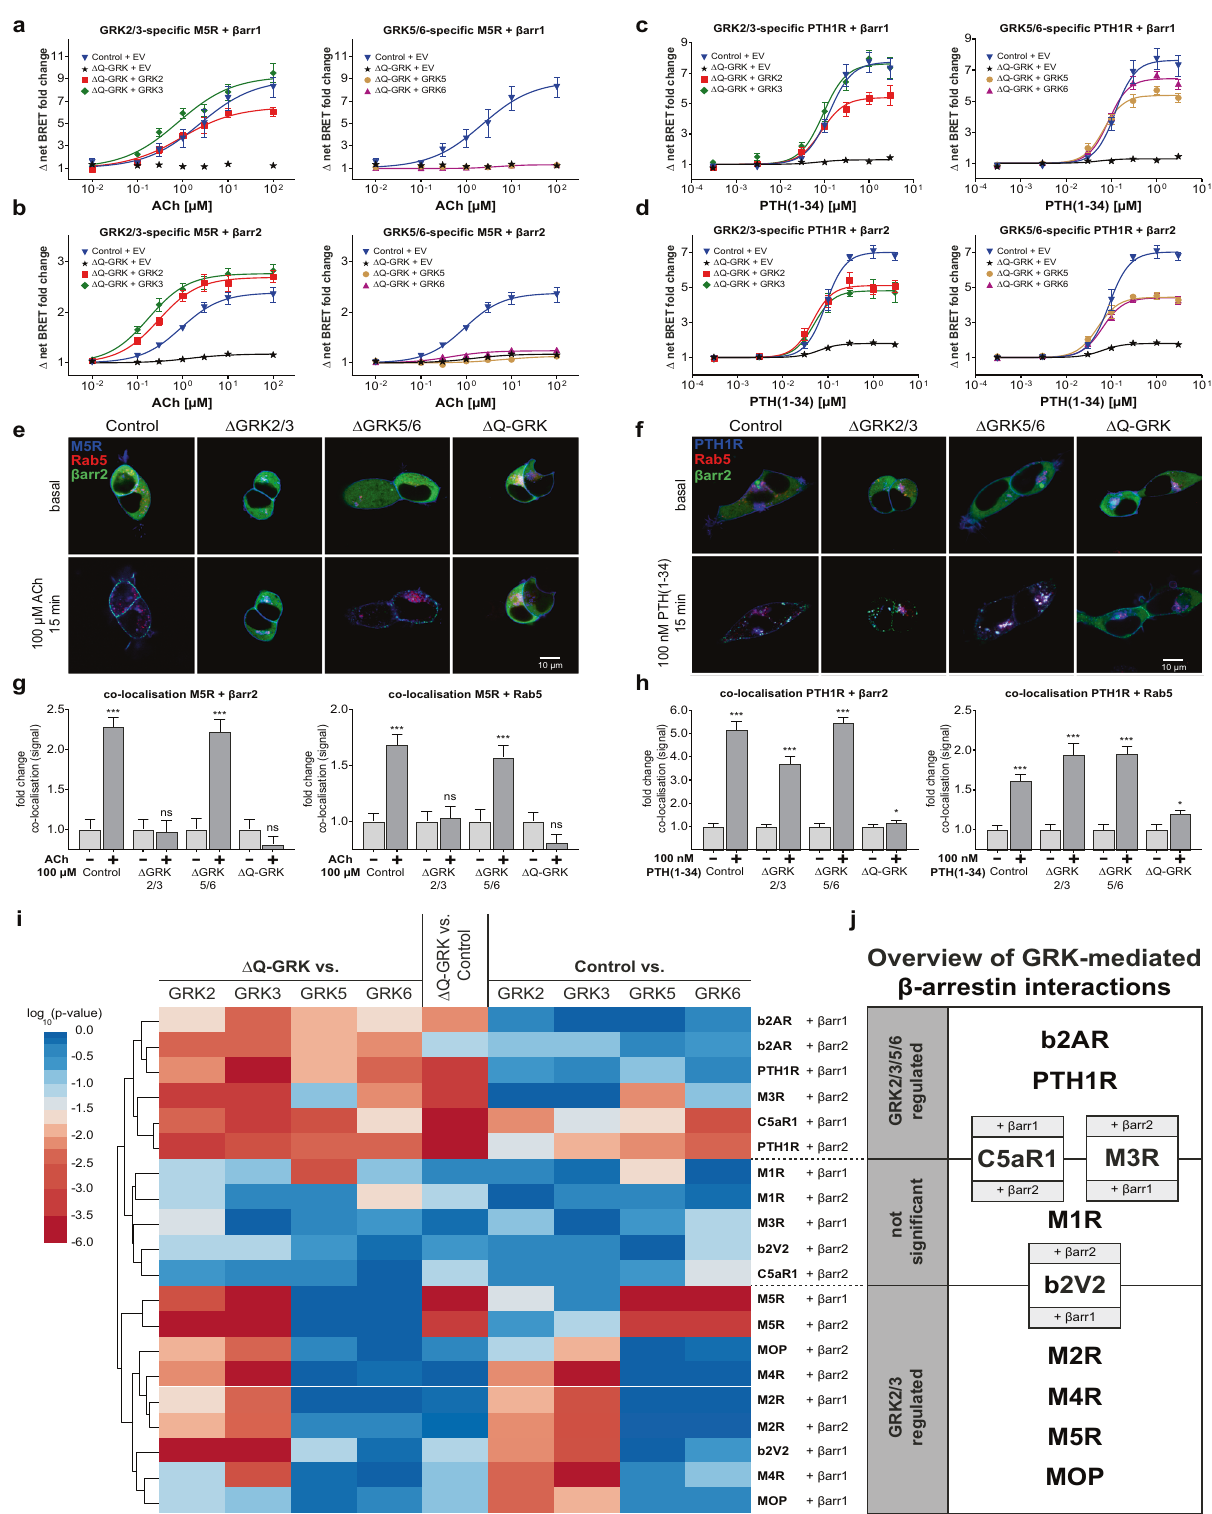
-arrestin1). Within our tested GPCRs, we did not observe β -arrestin interaction mediated exclusively by GRK5 or 6. A third group is comprised of receptor – β -arrestin pairs, which did not consistently show signi fi cant differences between the tested conditions and